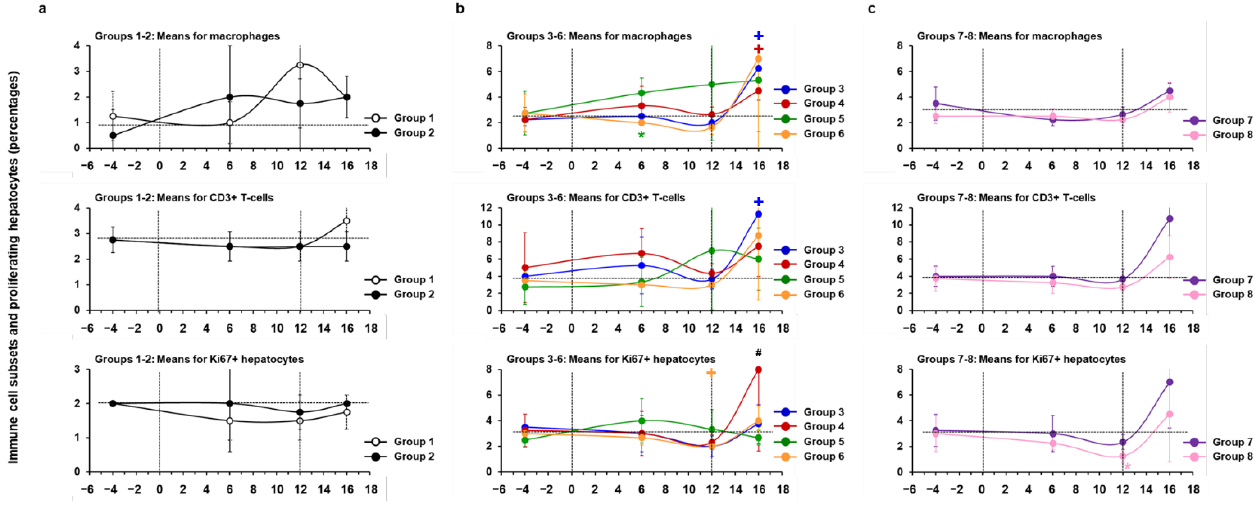
Figure 13. Treatment with hzVSF at the high dose or with TAF, alone and together with hzVSF at an intermediate dose, reduces the presence of intrahepatic immune cell subsets and lowers liver replenishment by new hepatocytes. Comparison of mean percentages of macrophages, CD3+ T-cells, and Ki67+ hepatocytes of ( a ) Groups 1 – 2 treated with placebo or hzVSF at a high dose, ( b ) Groups 3 – 6 treated with placebo or hzVSF at a low, intermediate, and high dose, and ( c ) Groups 7 – 8 treated with TAF, alone or in combination with hzVSF at an intermediate dose, relative to the pretreatment baseline (week – 4). Vertical lines indicate the standard error of the mean. Horizontal dotted lines present the mean percentage of Groups 1 – 2, Groups 3 – 6, or Groups 7 – 8 at baseline. Macrophages in Group 3 and Group 4 were significantly increased compared to the baseline after the EOS during weeks 17 – 19 (+: p < 0.05). Compared to Group 3 and Group 6, macrophages were significantly increased in Group 5 at week 6 (*: p < 0.05). CD3+ T-cells in Group 3 were significantly increased compared to the baseline after the EOS during weeks 17-19 (+: p < 0.05). Ki67+ hepatocytes in Group 6 were significantly reduced compared to the baseline at week 12 (+: p < 0.05). Compared to Group 7, Ki67+ hepatocytes were significantly reduced in Group 8 at week 12 (*: p < 0.05). # The mean Ki67+ hepatocyte percentage in Group 4 was 15.5%.